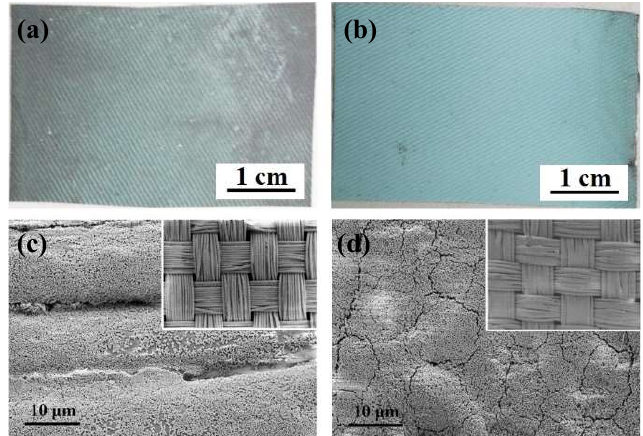
Figure 5. Photograph ( a , b ) and SEM images ( c , d ) of SiO 2 ( a , c ) and SiO 2 /P(MMA-BA) ( b , d ) APSs after soaping fastness test.